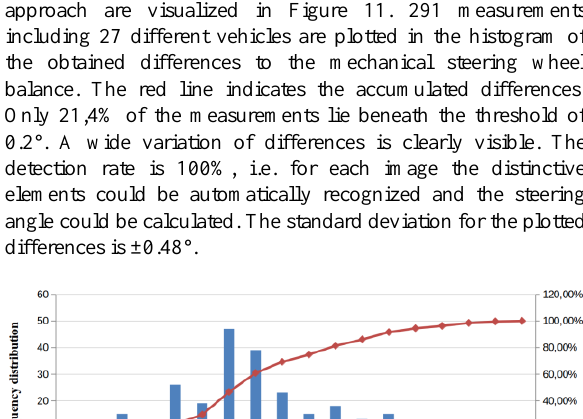
5.1.3 Point-to-Point Matching: The point-to-point matching was evaluated analogue to the 2D shape-based matching. The pair of points consists of one element (button) from the left side and one from the right side of the steering wheel as shown in Figure 6. The steering angle was computed in 45 images containing the same steering wheel in different rotations and poses. The results compared to the mechanical balance are shown in Figure 9. These are similar to those illustrated in Figure 7. However, the overall accuracy is slightly better resulting in a standard deviation of ±0.029°. The obtained values do not exceed 0.1° and lie far below the threshold of 0.2°.